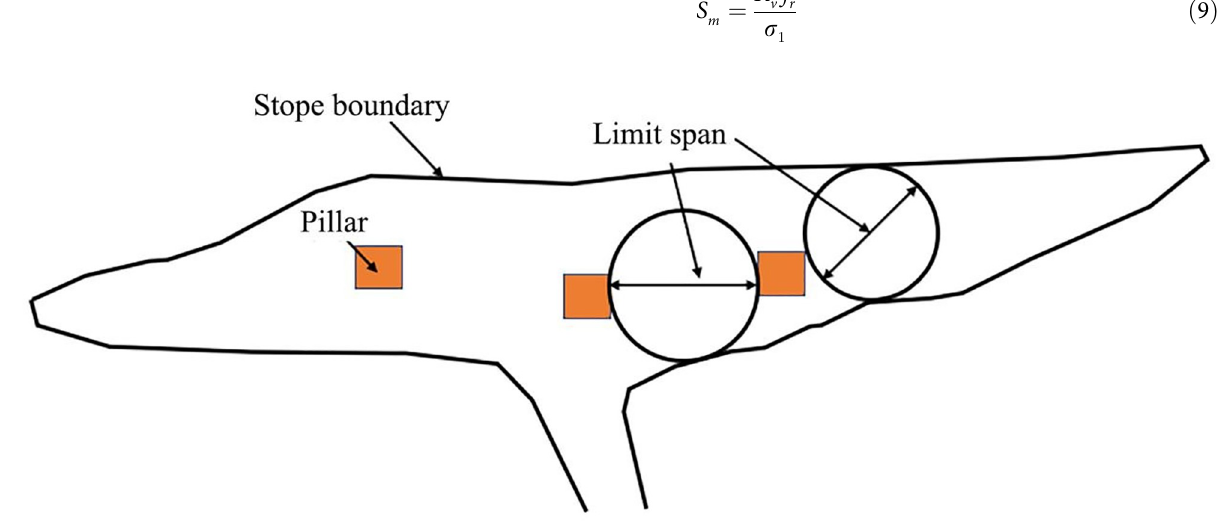
Fig 5. Determination of limit span of the